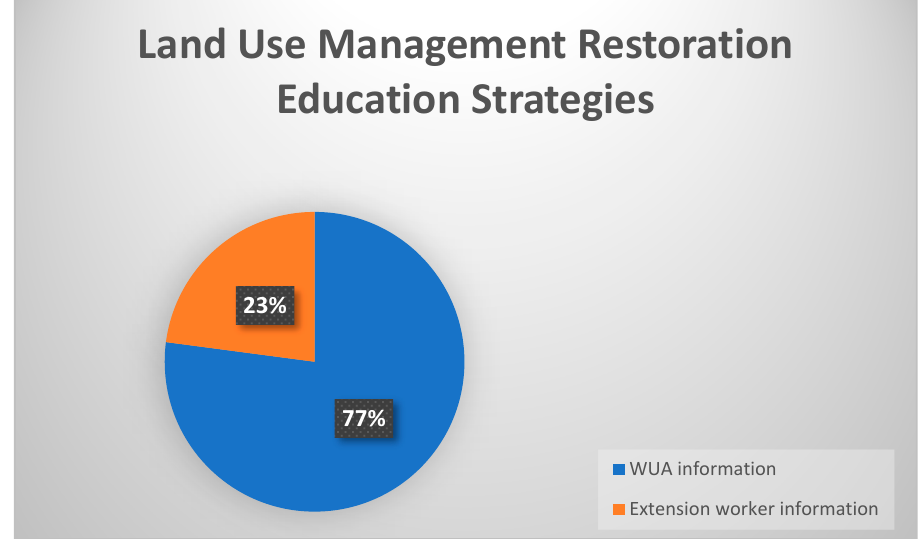
Figure 4. Non-WUA responses on the climate resilience education on land management.